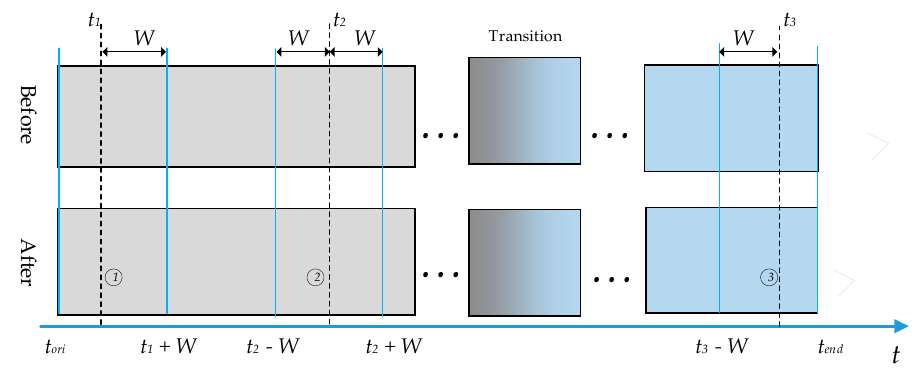
Figure 2. Description of the search range.